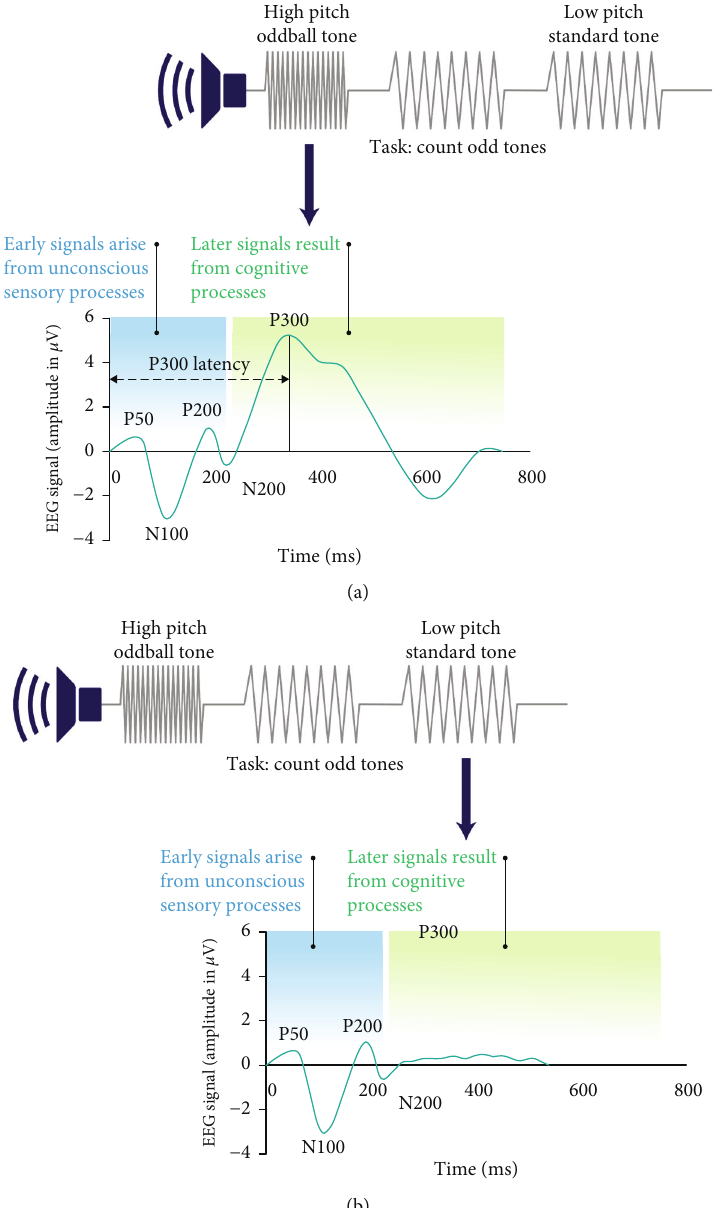
Figure 2: Schematic of the ERP P300 in the auditory oddball paradigm. The auditory oddball paradigm consists of a sequence of audio tones with randomized presentations of frequent (e.g., low-pitch [500-Hz] standard stimulus tones) and rare (e.g., high-pitch [2000Hz]) “ oddball ” tones, with interstimulus intervals (1.2 – 1.9s). Participants are tasked with counting the number of oddball tones (a). During the task, participants ’ brain activity is recorded with electrodes placed on the scalp. Brain waves are ampli fi ed, digitized, and fi ltered to produce an average waveform with positive (P) and negative (N) de fl ections: P50, P200, P300, N100, N200 amplitudes, and latencies. The brain produces a large positive de fl ection 300 ms (P300) after the presentation of an oddball tone, corresponding to recognition of the di ff erent stimuli and indicating the activity of the working memory. The amplitude and latency of the P300 can be compared between groups. (b) When a standard tone is presented, no large positive de fl ection is produced at 300ms, indicating that the tone is not registered in the working